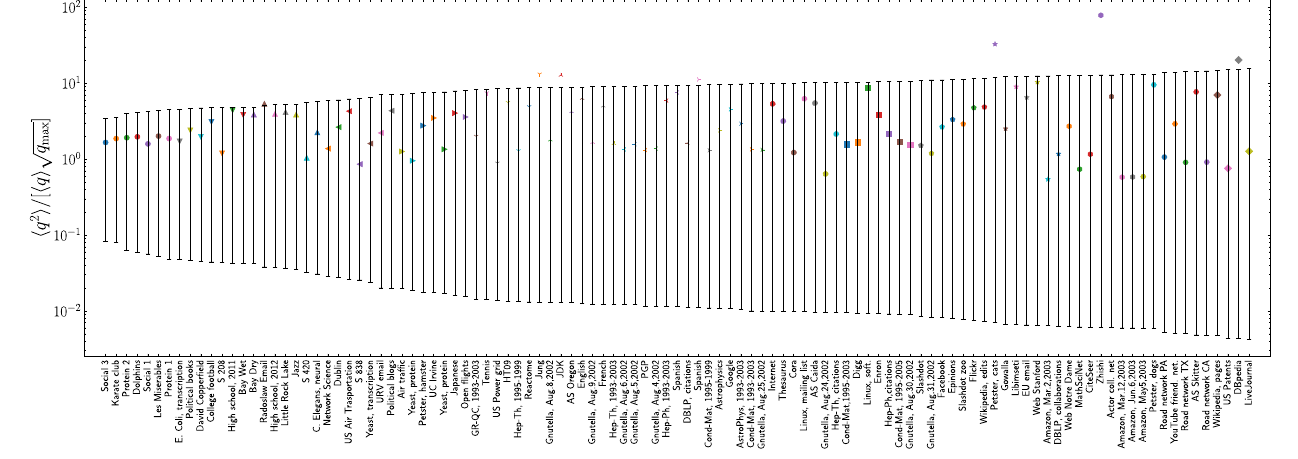
FIG. 8. For each of the real-world networks considered, we plot in log scale a line indicating the interval where Eq. (1) does not make any prediction. The symbols indicate the actual value of h q 2 i = ½h q i